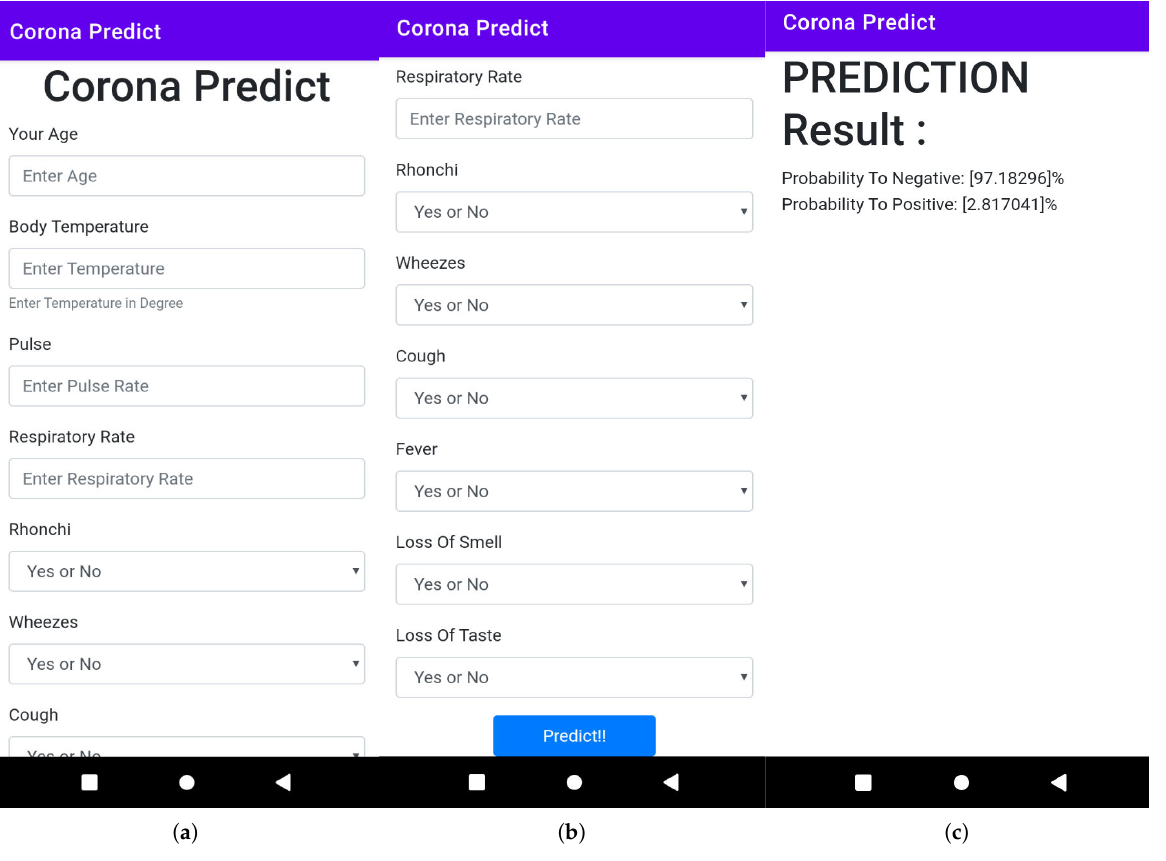
Figure 11. Several screenshots, such as ( a ) queries from users, ( b ) queries from users, and ( c ) pre- dicted results of the implemented mobile application for COVID-19 prognostication, deploying the proposed